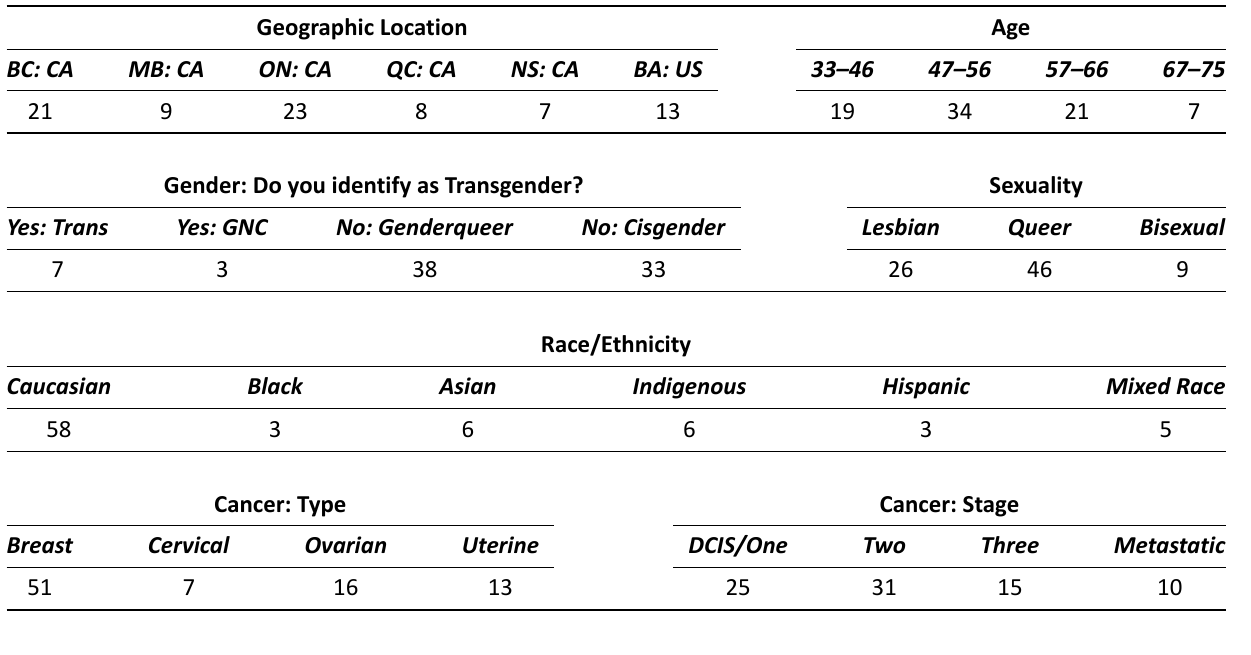
Table 1. Participant demographic